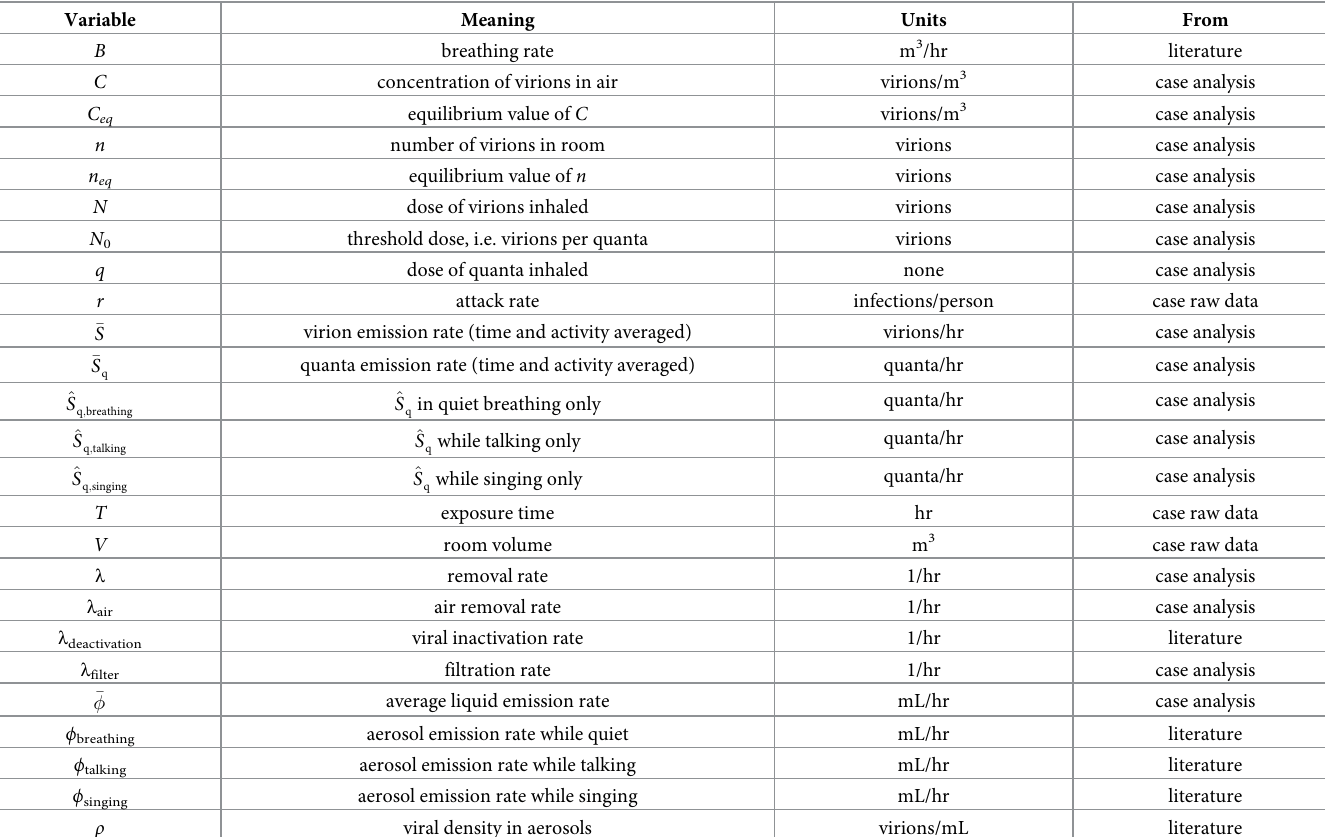
Table 1. List of